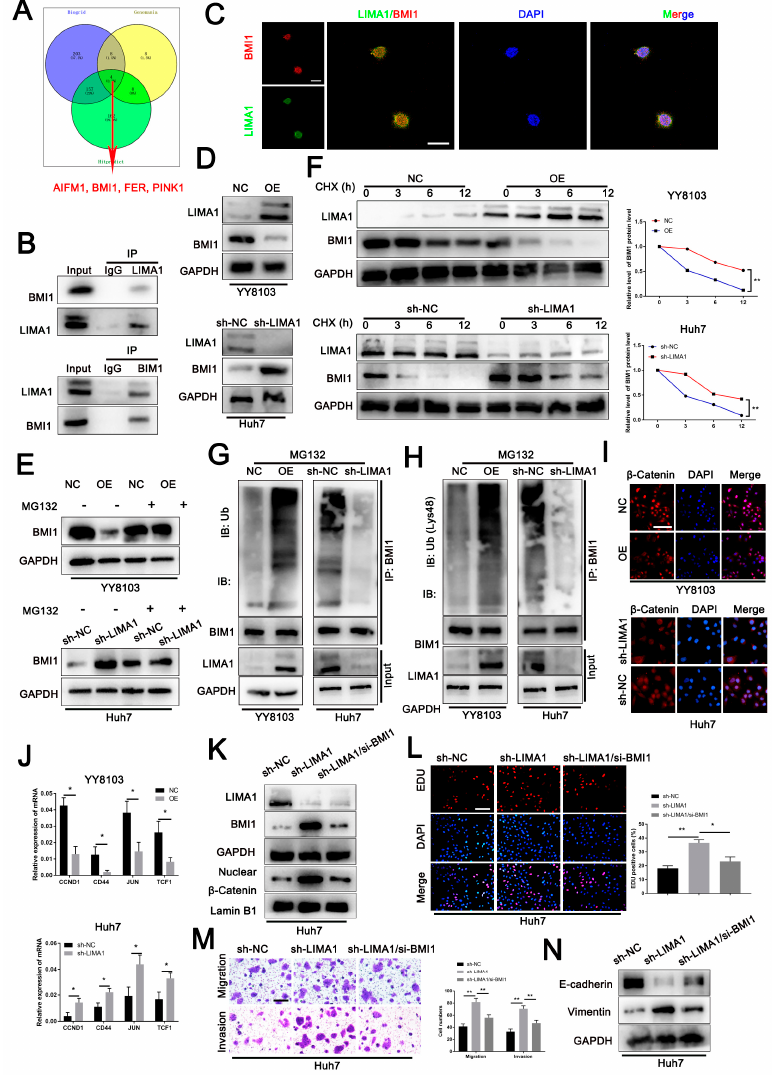
Figure 4. LIMA1 attenuated HCC progression by impairing the Wnt/ β -catenin signalling pathway. ( A ) A-protein interaction network was predicted for LIMA1 based on Biogrid, Genemania and Hitpredict databases. AIFM1, BMI1, FER and PINK1 were identified as the common interacting partners for LIMA1. ( B ) Co-IP assay and ( C ) immunofluorescence were performed to verify the interaction between LIMA1 and BMI1. ( D ) BMI1 expression levels with LIMA1 knockdown or overexpression were examined by western blotting. ( E ) MG132 (20 µ M) was used to pre-treat HCC cells with LIMA1 knockdown or overexpression for 8 h, and then BMI1 expression level was detected by western blotting. ( F ) HCC cells with LIMA1 knockdown or overexpression were treated with 100 µ g/mL CHX, collected at the indicated times, and then subjected to IB with antibodies against BMI1. The relative BMI1 degraded rate was quantified relative to GAPDH. Cell lysates from HCC cells with LIMA1 knockdown or overexpression were subjected to IP with anti-BMI1, followed by IB with antibodies against ( G ) Ub and ( H ) Ub (Lys48). ( I ) Immunofluorescence was performed to detect the translocation of β -catenin with LIMA1 knockdown or overexpression. ( J ) The downstream molecules of β -catenin were examined by RT-qPCR. ( K ) BMI expression and nuclear β -catenin level were verified in Huh7 cells with BMI1 and LIMA1 silencing. ( L ) EDU, ( M ) transwell and ( N ) EMT markers examination were performed to detect the rescued effect of BMI1 on LIMA1. * p < 0.05, ** p <